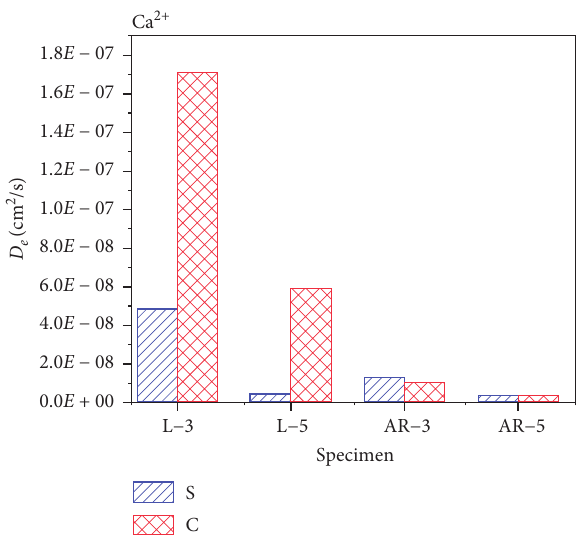
Figure 9: Effective diffusion coefficient of Pb 2+